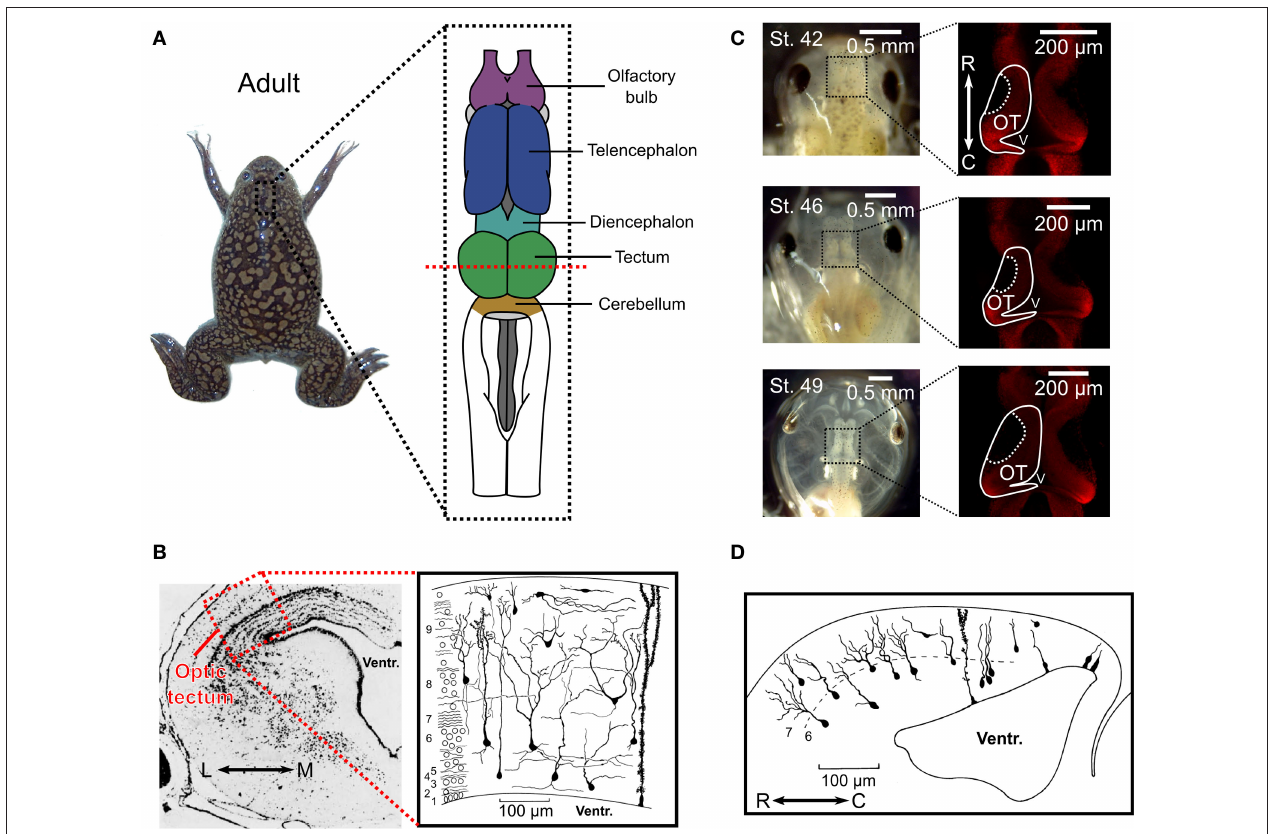
dorsally at stages 42, 46, and 49 illustrate the changes that occur during the stages in which STDP is typically studied. During this time the optic tectum grows, as shown by confocal images of whole-mount brains with propidium iodide staining for cell nuclei. The images shown are in the horizontal plane and at a depth of 100 μm from the dorsal surface of the brain (right). Note the dark regions in the rostral–lateral optic tectum which are comprised mostly of neuropil. Neurogenesis takes place in the caudal–medial region surrounding the ventricle. (D) Due to the location of the neurogenerative zone there is a progression in the maturity and morphological complexity of cells in the optic tectum at these ages in the caudal–rostral axis, as shown by this camera lucida drawing of a sagittal slice from a stage 49 tadpole. Images in (B) and (D) are reproduced with permission from Lázár (1973) and Nikundiwe and Nieuwenhuys